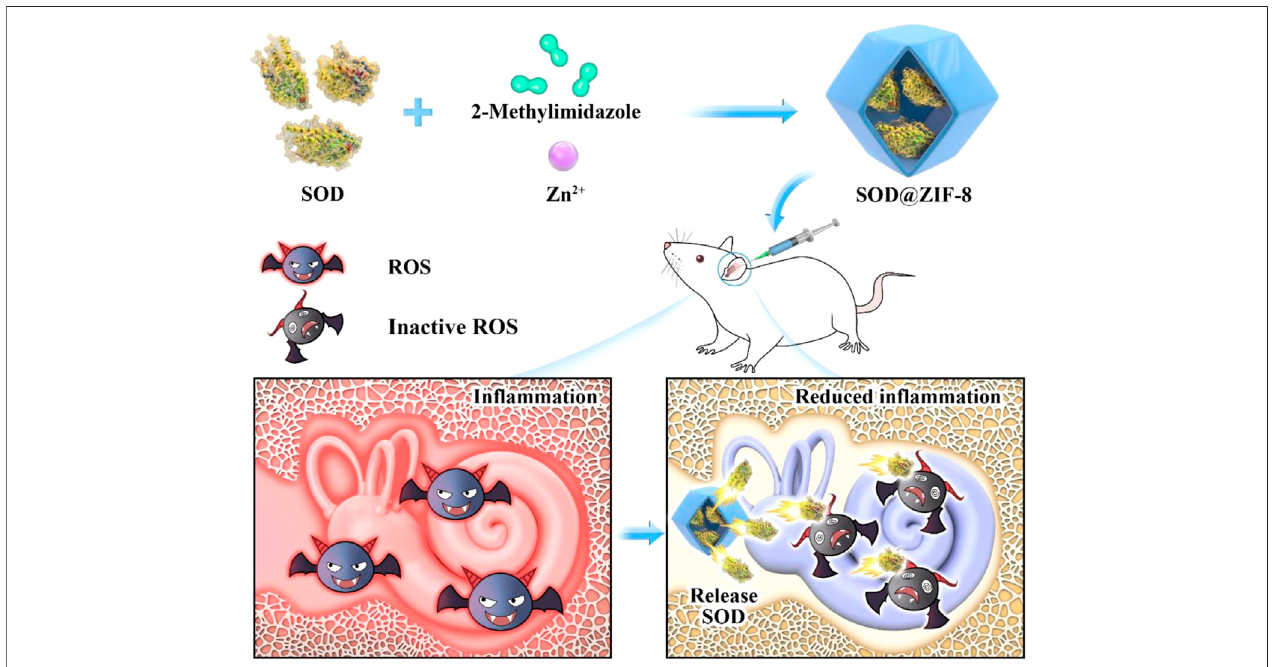
FIGURE1| Schematicillustratingthesyntheticprocessofsuperoxidedismutase(SOD)@zeoliteimidazolateframework-8(ZIF-8)anditsuseforthetherapyofinner ear diseases associated with reactive oxygen species (ROS).